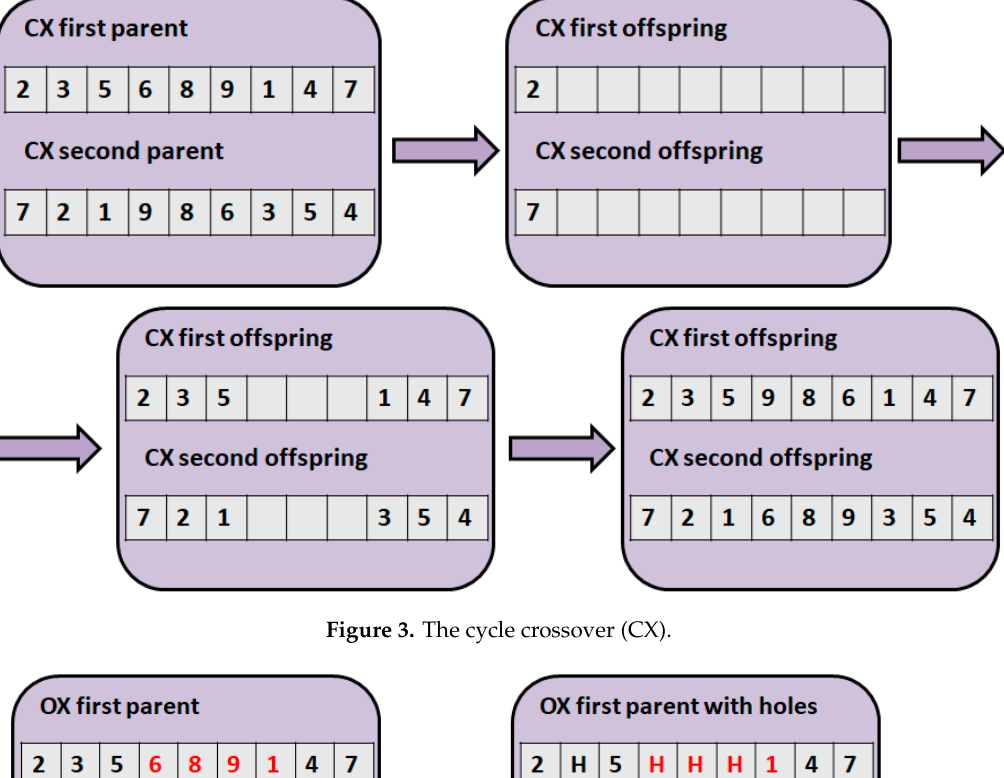
Figure 3. The cycle crossover (CX).